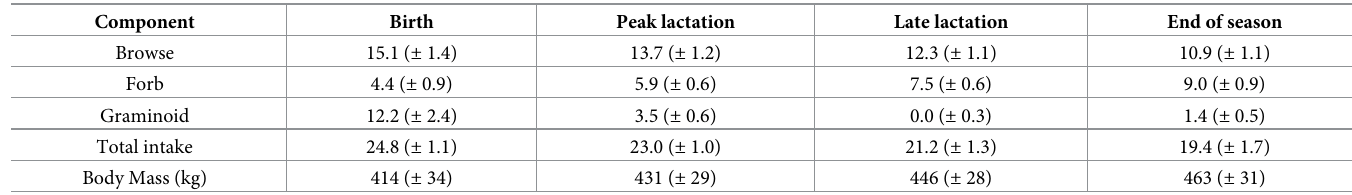
In this study, browse was the largest component of the diet through most of the summer, which is consistent with wild moose populations throughout western North America [35,52– 53] (S2 Table). A previous study at this site during a post burn period, birch leaves ( B . papyri- fera ) were 56% of the summer diet (number of bites) with the remaining diet being mostly forbs (25%); grasses, sedges and aquatics (10%); and a small amount of willow (5%) [54]. Dur- ing spring (late April-May), moose were observed eating a large amount of lichen ( Peltigera